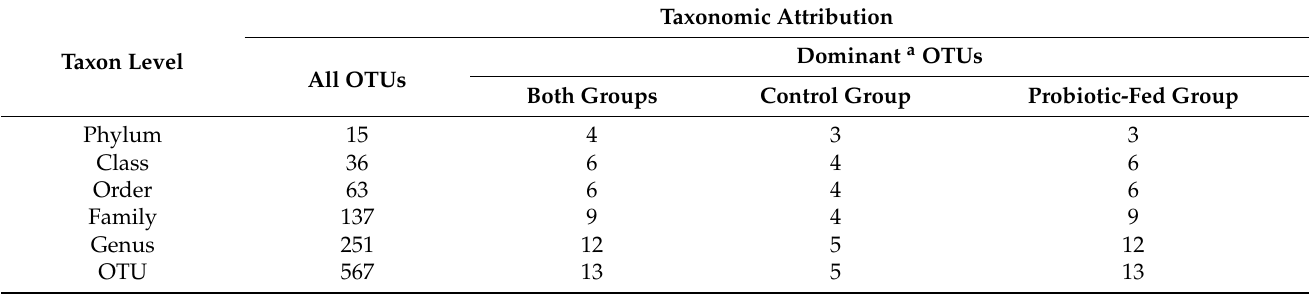
Figure 1. Rarefaction curves for the OTU number in fecal bacterial assemblages of the ducks. The total number of different-level taxa identified in the study is shown in Table 1. The mooutOTU-rich phyla were Proteobacteria (147 OTUs, or 26% of the total number of identi- fied OTUs) and Firmicutes with (134 OTUs, or 24%), followed by Actinobacteria (131 OTUs, or 23%) and Bacteroideteout 25 OTU, or 4%). Taxonomic richness in the studied samples was found to drastically decrease if only the dominant members, i.e., the ones contributing at least 1% into the total number of sequence reads, of the bacterial assemblages, were taken into account (Table 1). Table 1. Taxonomic richness of fecal bacterial assemblages of